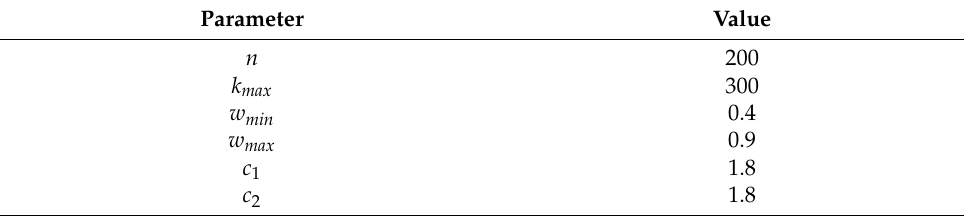
Table 6. Parameters of the PSO model.